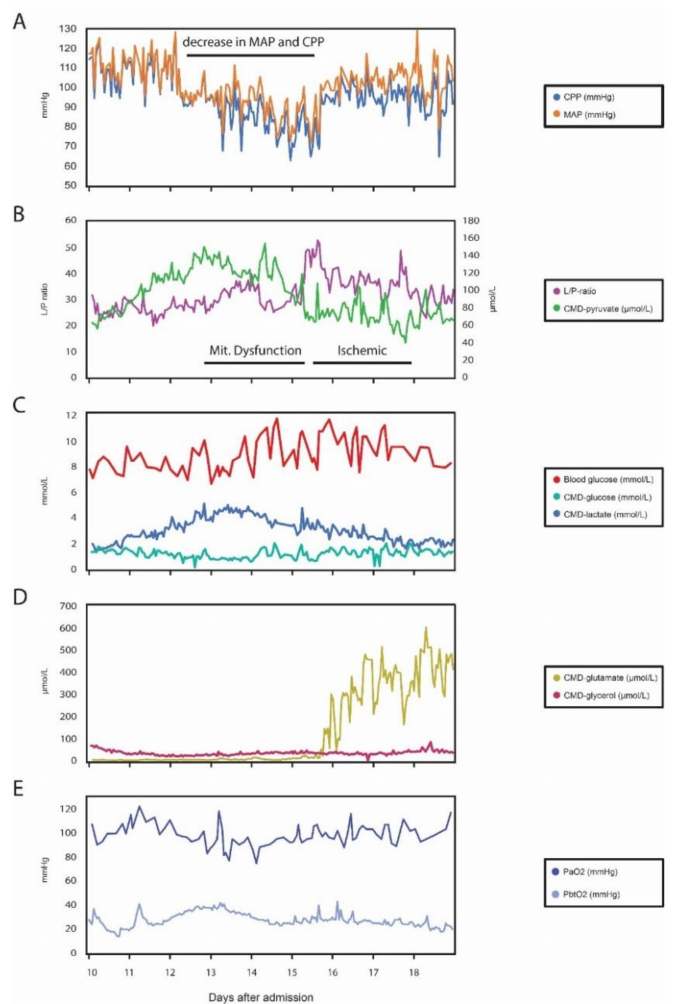
Figure 2. ( A ) Cerebral perfusion pressure (CPP) and mean arterial blood pressure (MAP) were gradually lowered from day 12 after admission. Intracranial pressure (ICP) is the di ff erence between the two curves; it is stable and below 10 mmHg. ( B ) Lactate-pyruvate (L / P)-ratio is seen greatly increasing at day 15 after admission, with a max value of 52.8. Before this a pattern of mitochondrial dysfunction is present (increased L / P-ratio, despite normal or elevated cerebral microdialysis (CMD)-pyruvate). An ischemic pattern is present hereafter (increased L / P-ratio, combined with a decrease in CMD-pyruvate). The di ff erence in both CMD-pyruvate and L / P-ratio was statistically significant ( p < 0.05), when compared in regard to the time periods before and after the steep increase in L / P-ratio ( +/ − 2.5 days). ( C ) Blood glucose, CMD-glucose and CMD-lactate. A decrease in CMD-glucose (min. value 0.67 mmol / L) is seen at the same point as the steep increase in L / P-ratio, despite intact blood glucose (7.8 mmol / L). After this time point, blood glucose increased, despite insulin infusion, and became increasingly di ffi cult to stabilize. CMD-glucose increased slightly compared to before the steep L / P-ratio increase. It should be noted that CMD-glucose is dependent on blood glucose. Consequently, high blood glucose can mask low CMD-glucose values. CMD-lactate decreases slightly after day 15, but relatively less than pyruvate, resulting in an increase in L / P-ratio. All changes were statistically significant. ( D ) CMD-glutamate and CMD-glycerol. CMD-glutamate increased sharply after the change from mitochondrial dysfunction to an ischemic pattern at day 15 after admission, possibly indicating cerebral excitotoxicity. CMD-glycerol is stable for the entire period. ( E ) Arterial partial pressure of oxygen (PaO2) and cerebral oxygen tension (PbtO2). From day 15 after admission the PbtO2 decreased, despite a parallel increase in PaO2 and CPP. The di ff erence in PbtO2 was statistically significant. The time resolution for the CMD samples is 1 sample pr.